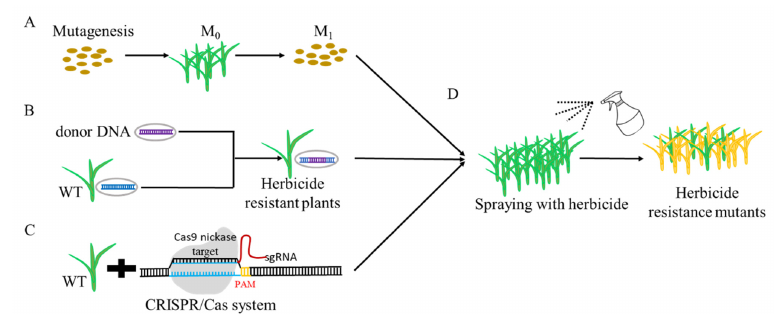
Figure 1. Creation of herbicide-resistant breeding crops. ( A ) Crop breeding by mutagenesis method. ( B ) Crop improvement by transgenic technology. ( C ) Crop genetic breeding through CRISPR/Cas system. ( D ) Screening resistant-plants with herbicide